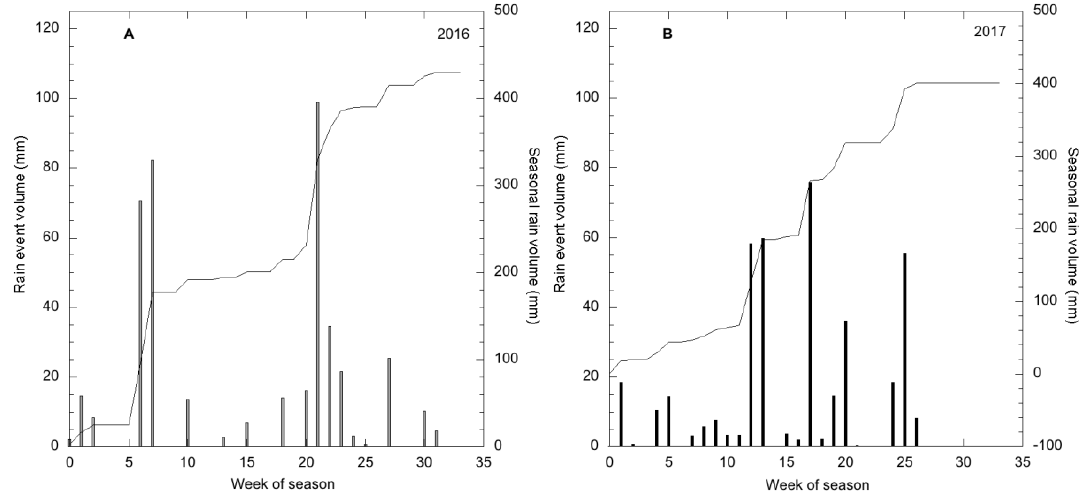
Figure 6. The amounts and pattern of rain events over the 2016 ( A ) and 2017 ( B ) study years. Week 1 starts on DOY 90. The bars represent weekly rain totals and the solid line represents the cumulative rain.